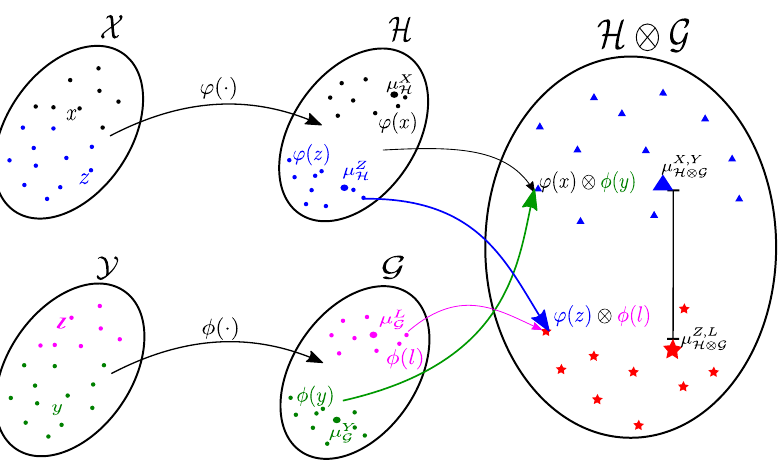
Figure 1. Schematic illustration of our EHECCO-based metric. Input spaces X and Y are mapped to RKHSs H and G , respectively. Then, the tensor space H ⊗ G is built using a cross-covariance operator